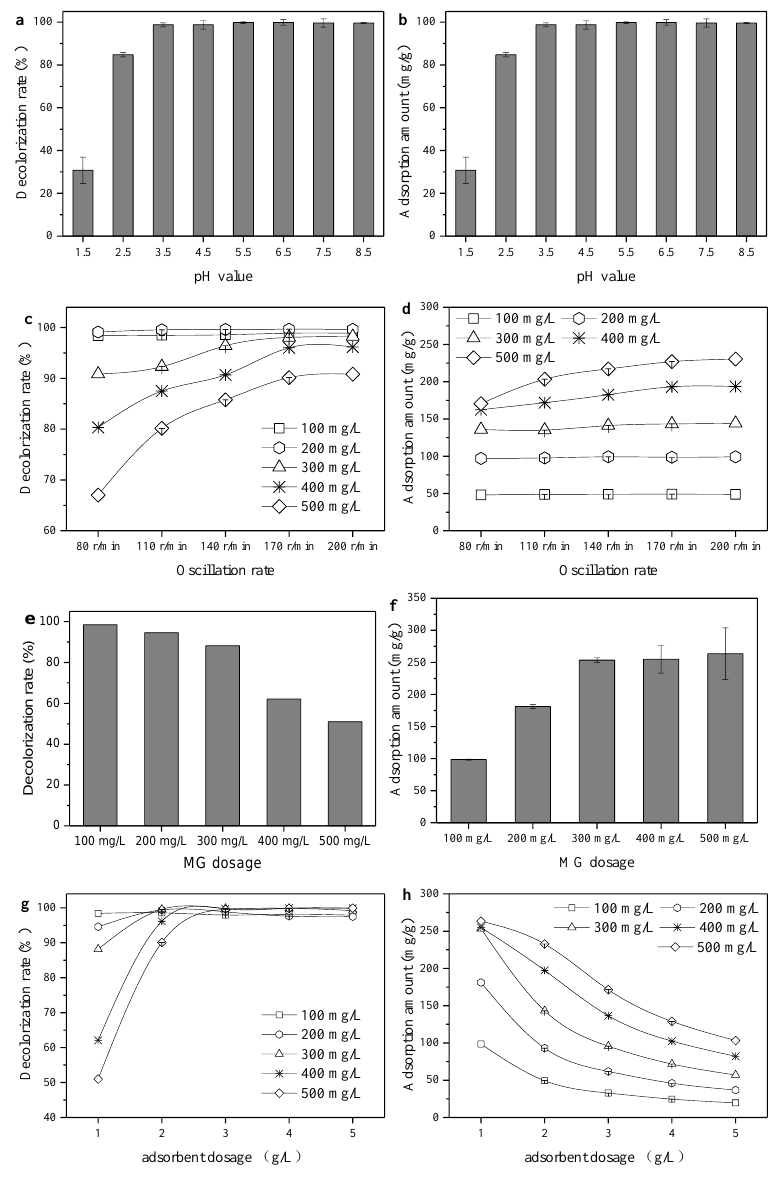
Figure 5. Impact of pH, oscillation rate, MG dosage and adsorbent dosage on adsorption performance. In ( a ) and ( b ), the adsorption test was conducted with a 300 mg / L MG solution and 2 g / L modified sepiolite for 120 min under an oscillation rate of 170 r / min and a temperature of 25 ◦ C; in ( c ) and ( d ), the adsorption test was conducted for 120 min with 2 g / L of modified sepiolite under an initial pH value of 9 and a temperature of 25 ◦ C; in ( e ) and ( f ), the adsorption test was conducted for 120 min with 2 g / L of modified sepiolite under an initial pH value of 9, an oscillation rate of 170 r / min, and a temperature of 25 ◦ C; in ( g ) and ( h ), the adsorption test was conducted for 120 min with an oscillation rate of 170 r / min under an initial pH value of 9 and a temperature of 25 ◦